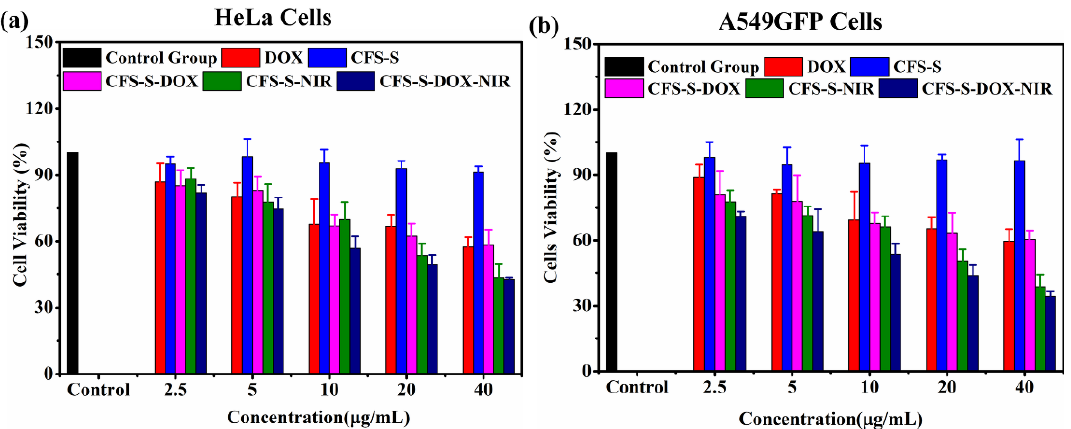
Figure 5. Cytotoxicity assays of ( a ) HeLa cells and ( b ) A549GFP cells with various treatments: CFS-S, DOX, CFS-S upon irradiation, and CFS-S-DOX with or without irradiation.